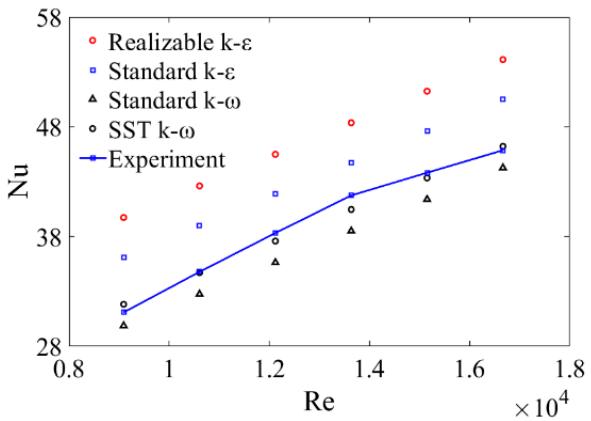
Figure 3. Comparison of different models of 𝑃𝑅 = 1.5, 𝑅𝐴 = 30°.